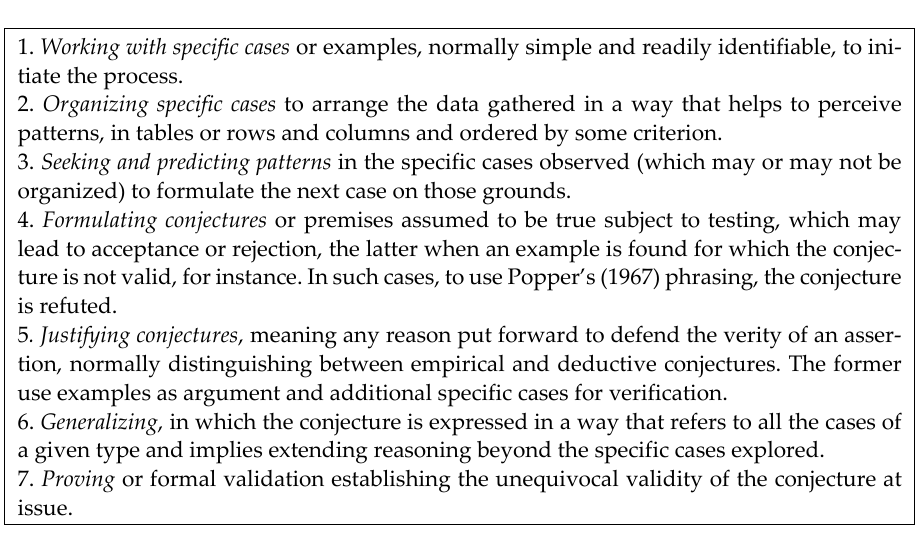
Figure 2. Inductive reasoning model proposed by [9]. Reproduced with permission of Cañadas, M.C.; Castro.